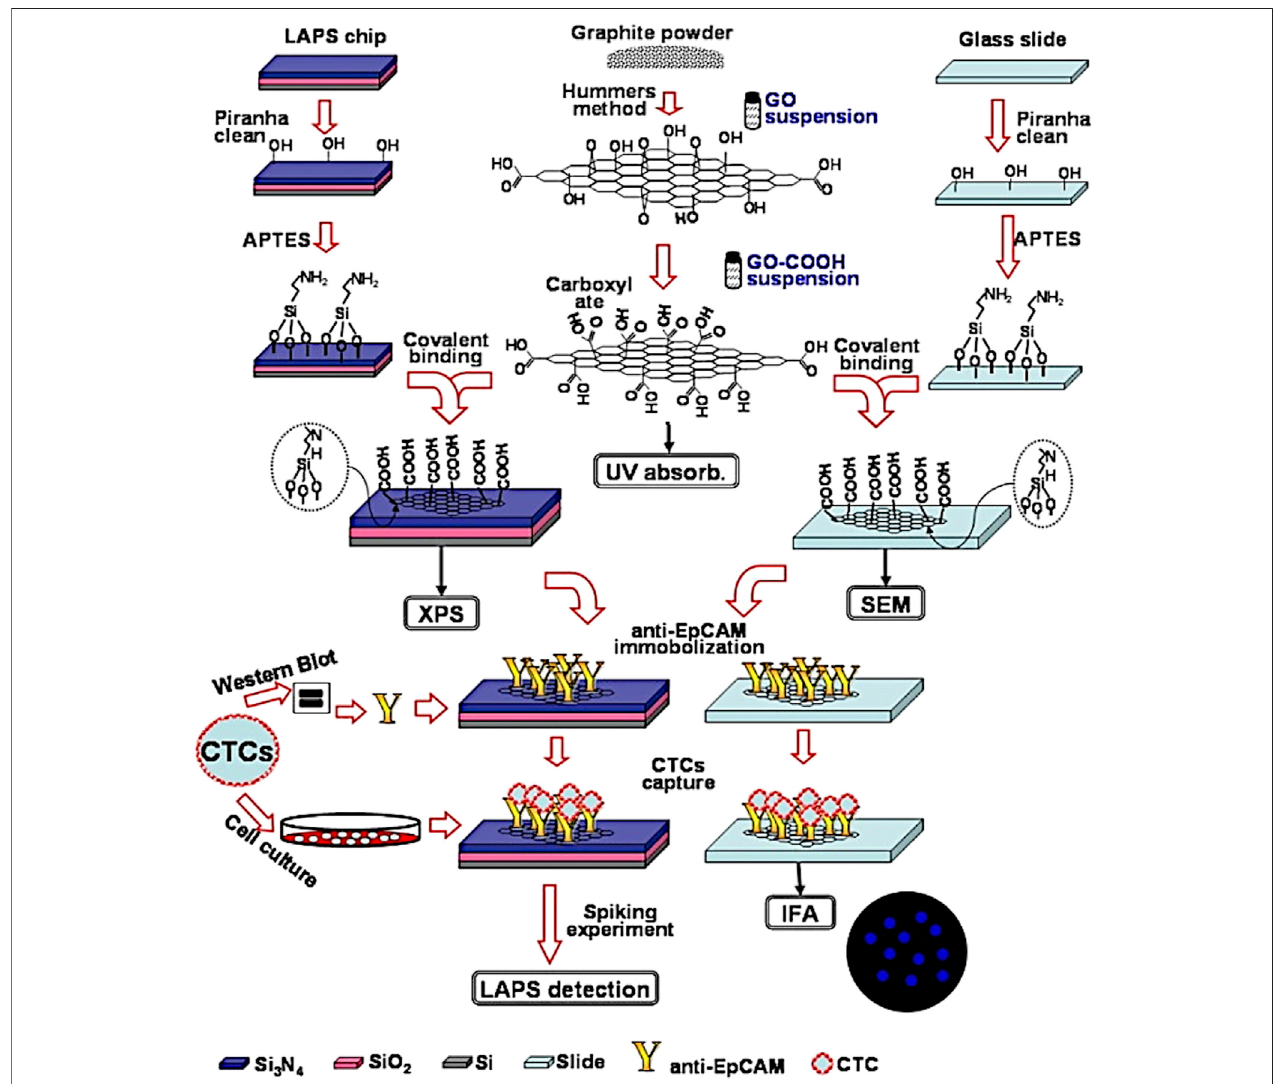
FIGURE 13 | Overview of the synthetic procedure and analytical protocols for CTC-LAPS (Figure adapted from Ref (Gu et al., 2015)).